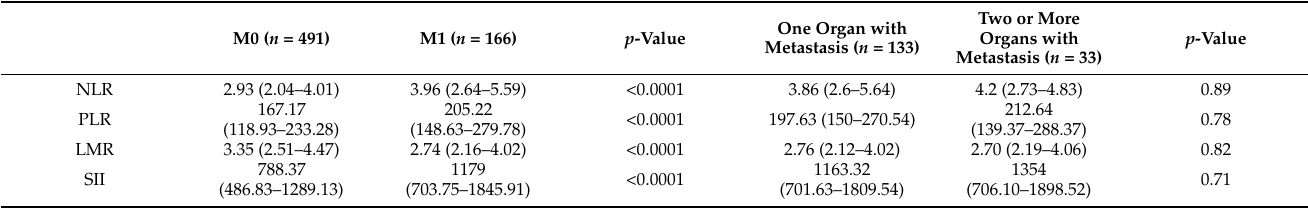
Table 4. The association between inflammatory ratios at presentation and presence of metastasis in one or more organs.